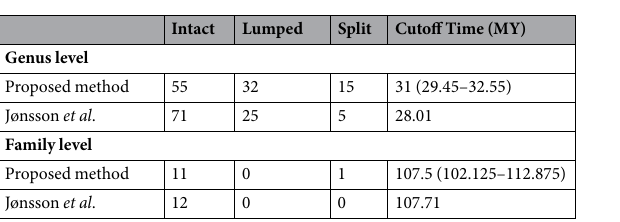
Table 1. Comparison of resulting new classification from the proposed temporal banding method and the method by Jønsson et al . 29